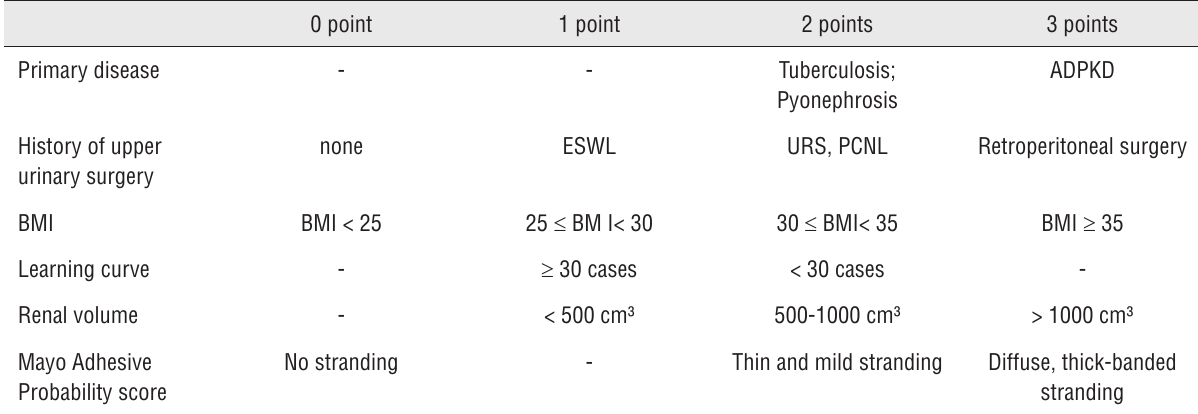
Table 1 - The Harbin Medical University Nephrectomy